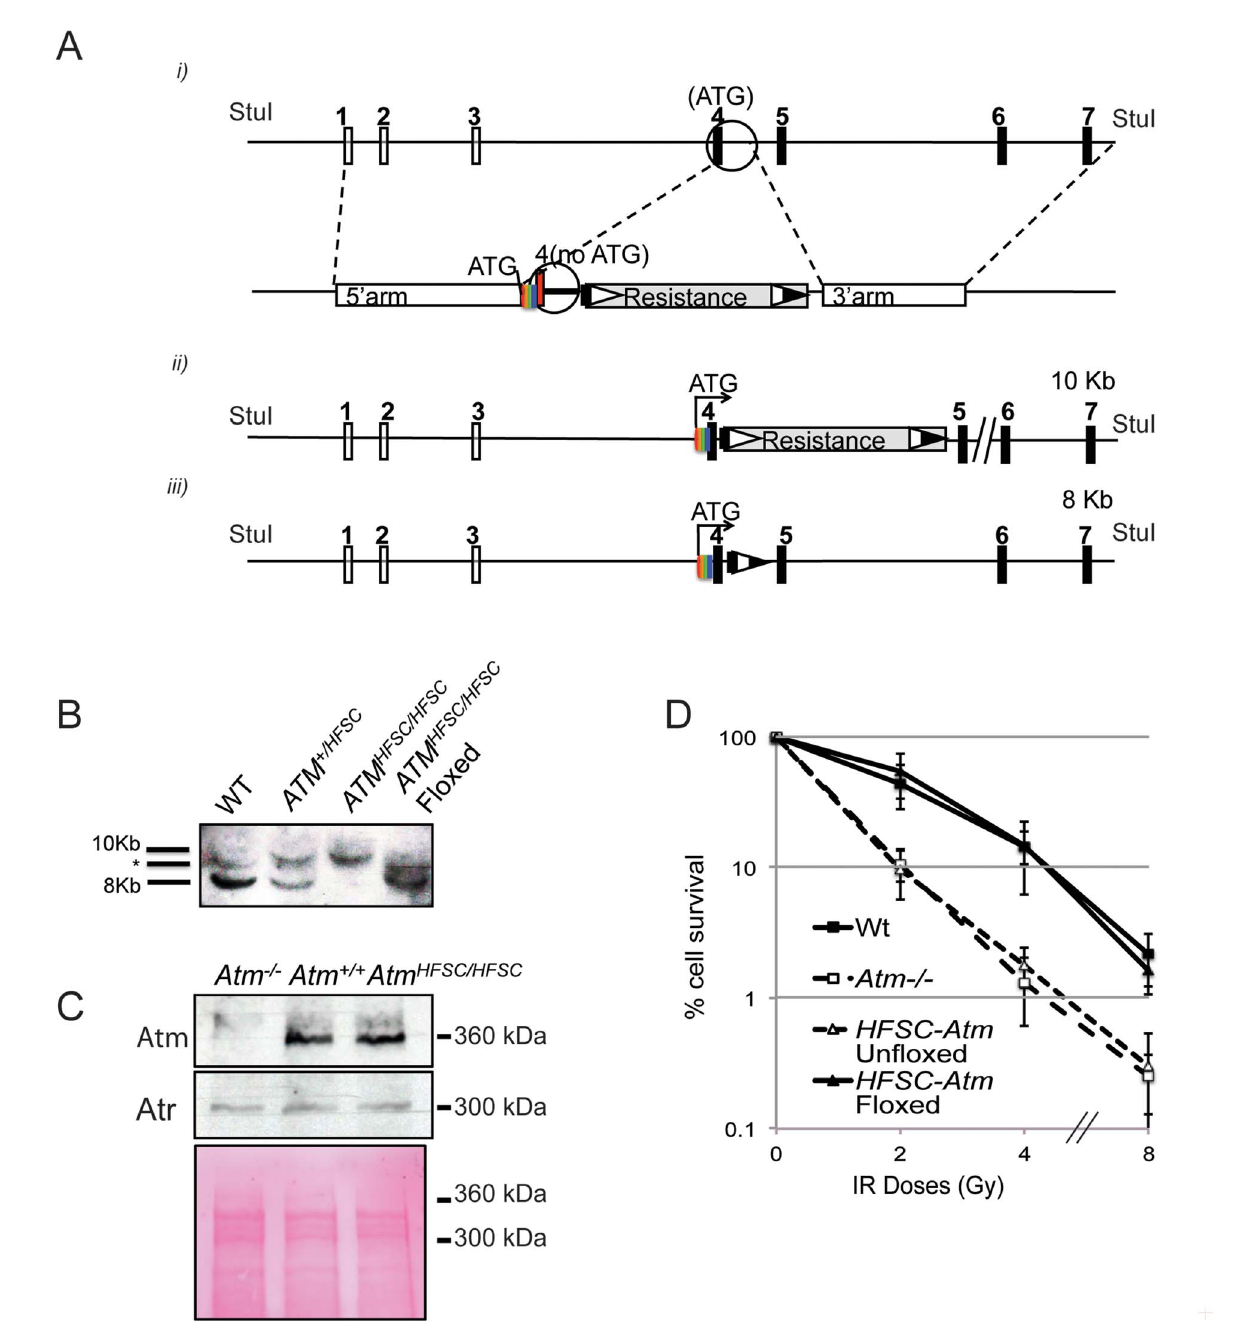
Figure 1. Targeting the Atm locus to generate the HFSC–Atm cell line. (A) Schematic of the chicken Atm locus with noncoding and coding exons indicated by open and filled rectangles, respectively. ( i ) Knock-in strategy, the 5 9 targeting arm spans from the first noncoding exon to the first coding exon. The HFSC tag was synthesized in frame with the Atm genomic sequence, excluding the endogenous ATG, and extending into the intron between the first two coding exons. It was fused to the 5 9 targeting arm by PCR and cloned into the targeting vector. The 3 9 targeting arm commences precisely where the synthesized DNA ended and extends to beyond the fourth coding exon. ( ii ) Structure of the Atm locus after targeting and before floxing. ( iii ) Structure of the Atm locus after floxing. The StuI sites indicate the DNA fragments detected by Southern blot analysis, corresponding to , 8 kb for both the WT locus and the floxed locus and to , 10 kb for the locus after gene targeting by prior to floxing. (B) Southern blot demonstrating successful gene targeting (the asterisk indicates an unspecific band). (C) Western blot demonstrating normal expression of HFSC– Atm in the indicated cell lines. (D) Clonogenic survival analyses of the indicated cell lines at the indicated IR doses. doi:10.1371/journal.pbio.1001856.g001 Human SNF2H is also a component of the ACF1/WRCF, BAZ1A (also termed ACF1) and BAZ1B components of the ACF/ CHRAC, and WICH chromatin remodelling complexes, whereas WCRF and WICH complexes, respectively, were also identified in RSF1 is specific to the RSF complex alone [7,8]. Of note, the our human ATM immunoprecipitates (Figure S2A, S2B, and S2C)